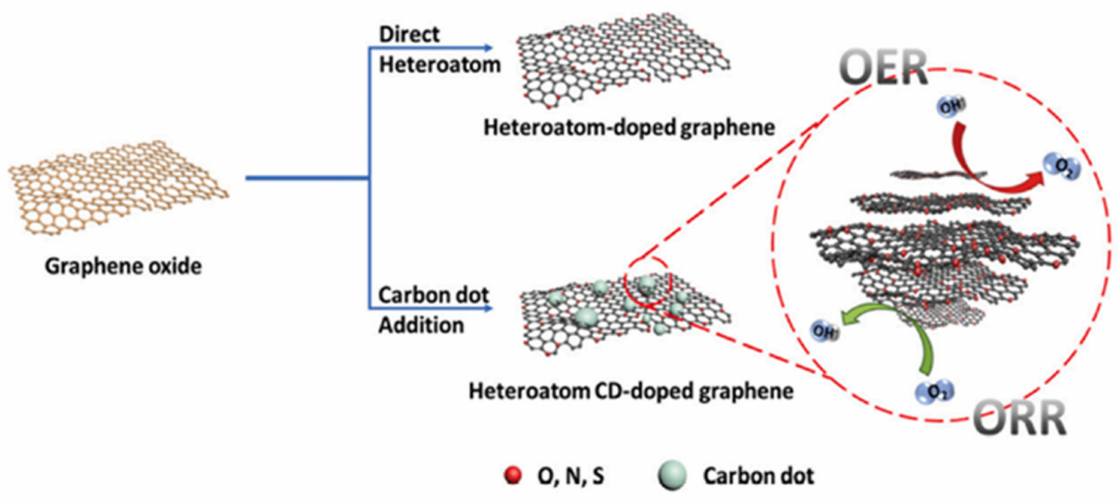
Figure 14. The schematic preparation process of NS-CD@gf